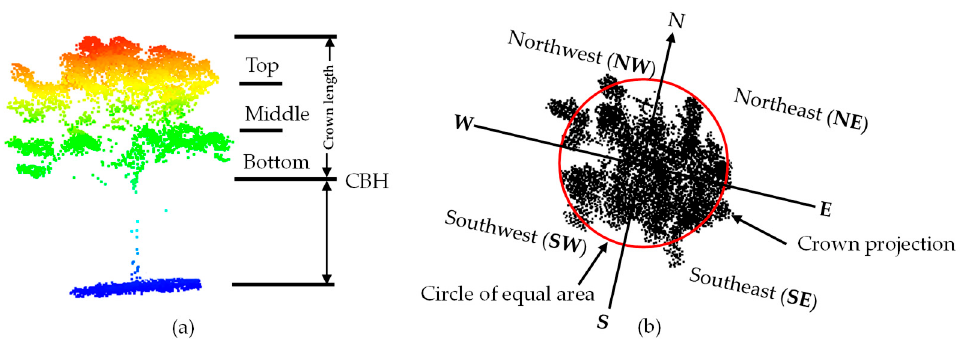
Figure 4. The different spatial arrangement of tree crowns; ( a ) the vertical height; and ( b ) the horizontal